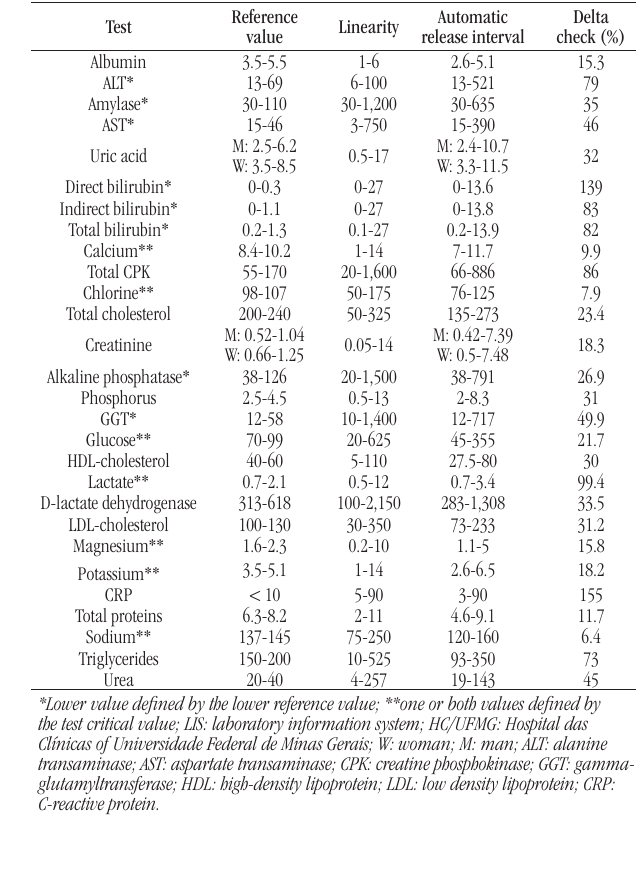
taBLE 2 − Parameters used for configuration of tests in the LIS at the core laboratory of HC/UFMG